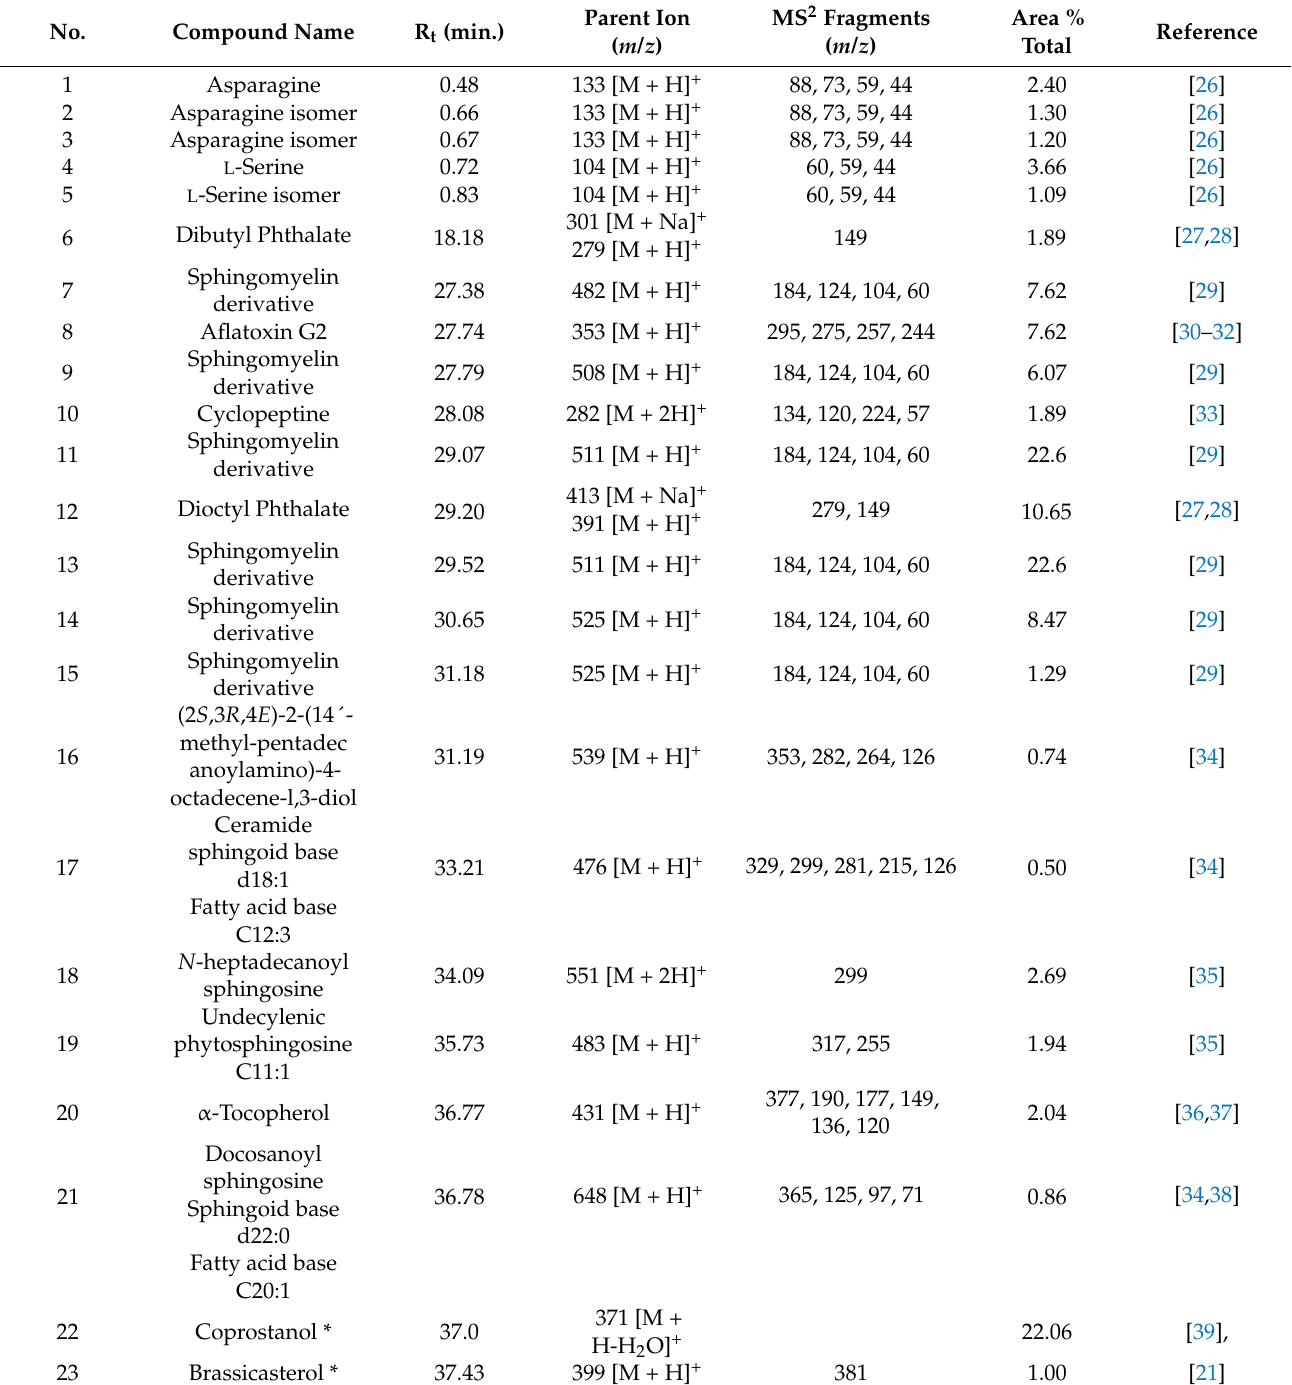
Table 1. Metabolites tentatively identified from n -hexane fraction using UPLC-ESI-MS/MS analysis in positive ionization